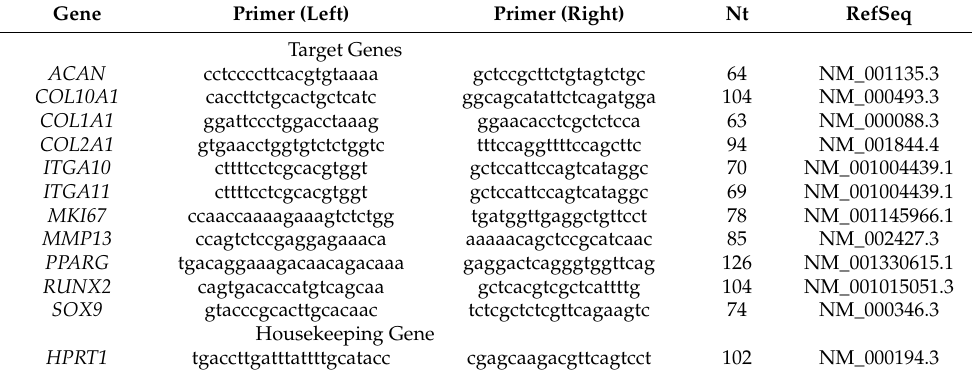
Table 1. Summary of target and housekeeping genes for qPCR. (nt = nucleotides, RefSeq = reference